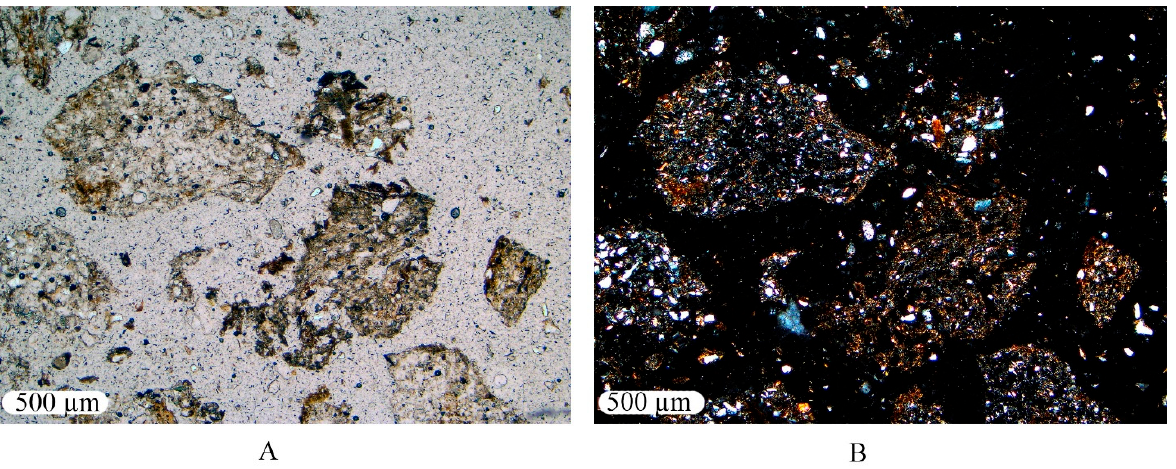
Figure 5. Micromorphological structure of the pasture soil Y6 Ahd 1 profile. ( A ) plane polarized light; ( B ) crossed polarized light.